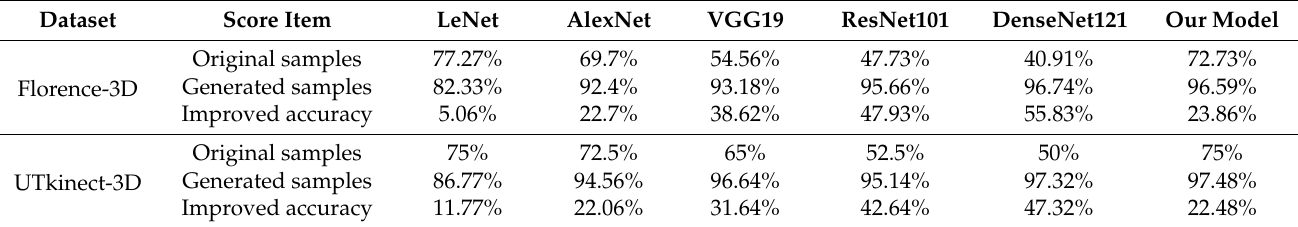
Figure 5. Training process of multiple CNN models based on original samples of Florence-3D (a) and UTkinect-3D (b). Table 2. Comparison of the test accuracy of different CNN models on original images and generated images of Florence-3D dataset and UTkinect-3D dataset.